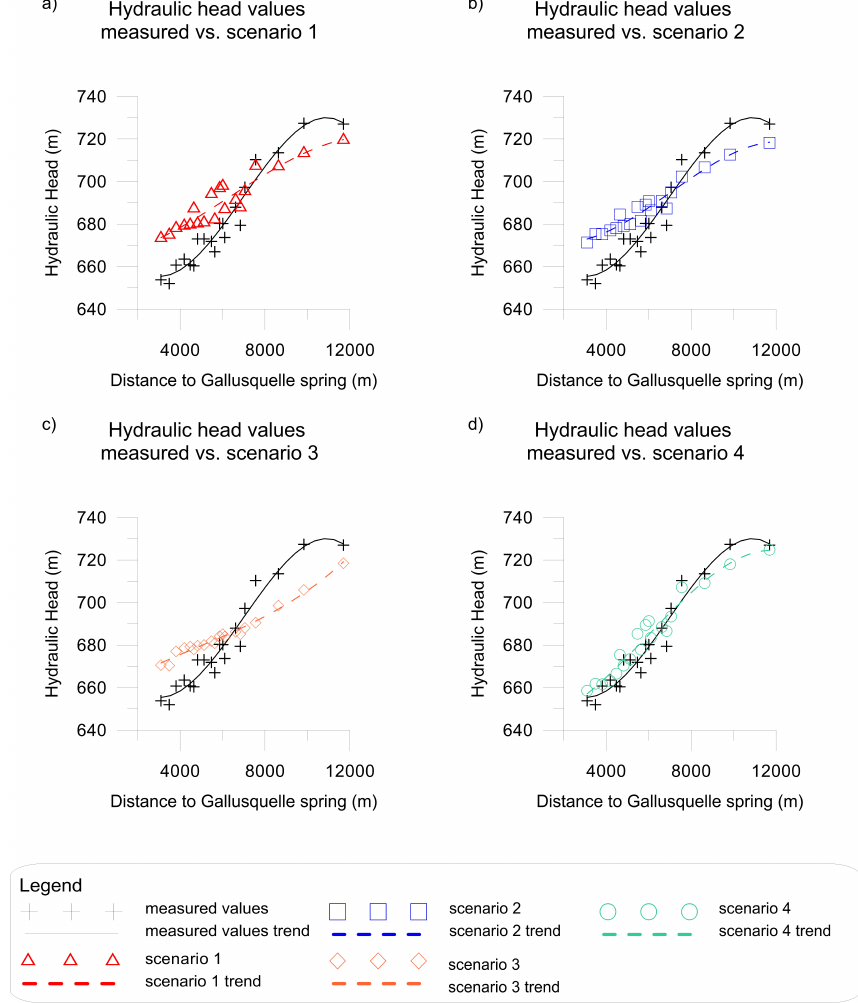
Fig. 6. Comparison of the hydraulic head values measured in the observation wells and those simulated at the well positions. (a) after the homogeneous simulation. (b) after the simulation with fracture flow along the northern fault of the Hohenzollerngraben. (c) after the simulation with a 1-D conduit network with constant radius. (d) after the simulation with a 1-D conduit network with increasing